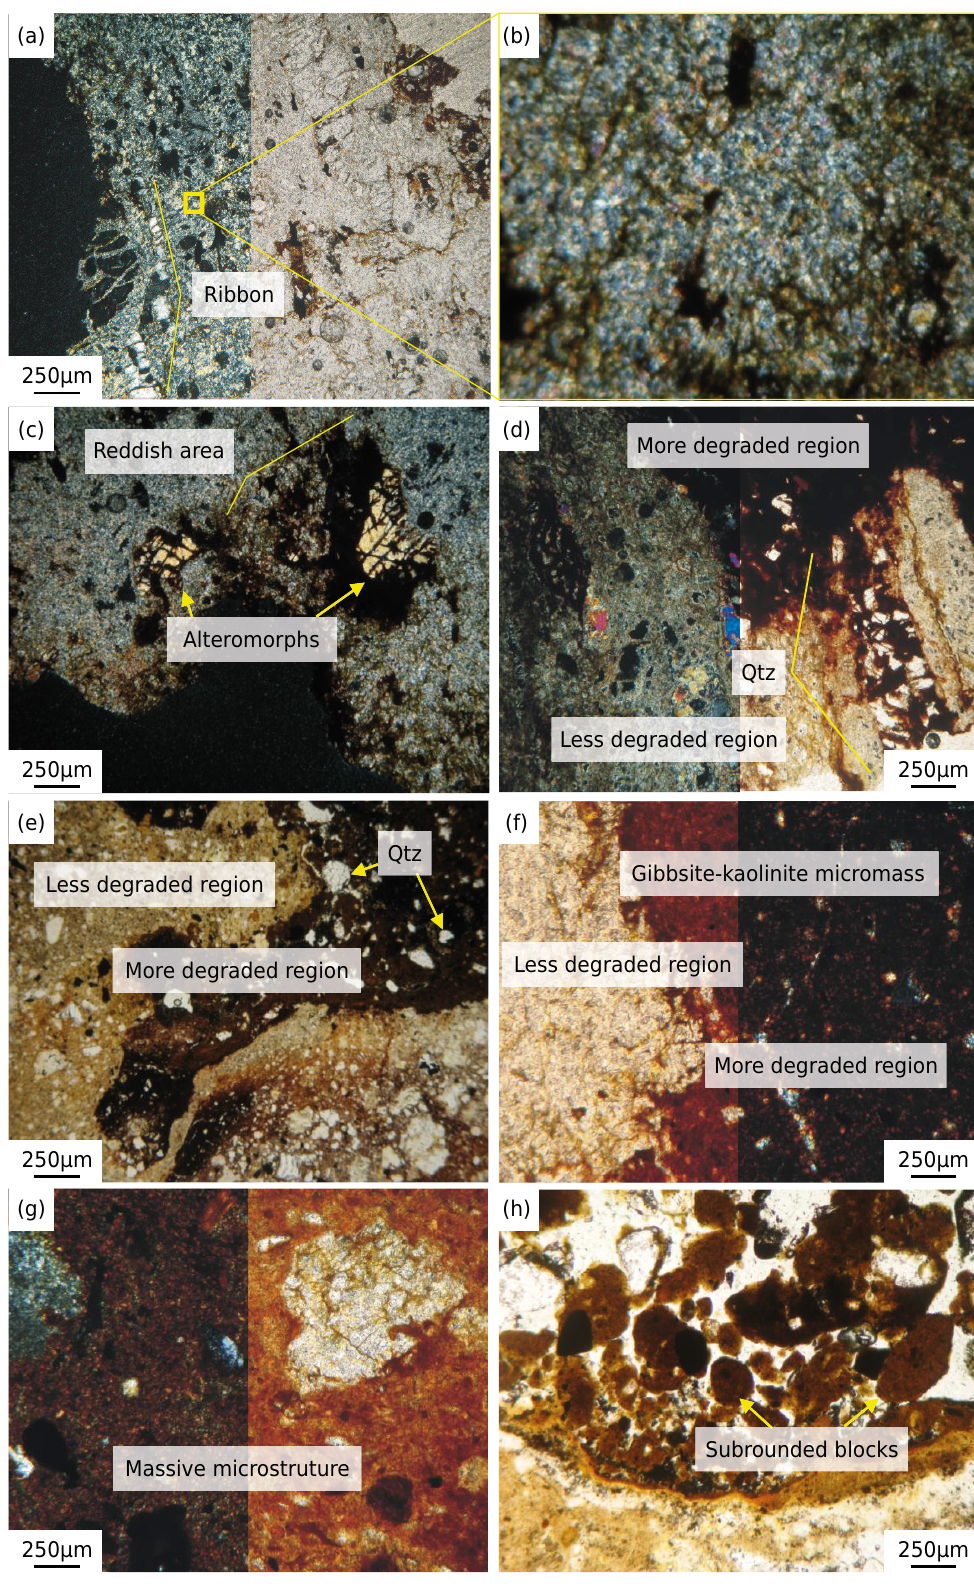
Figure 4. Photomicrograph of bauxite fragments. PPL: plane polarized light; XPL: crossed polarized light; Qz: quartz. (a) Less degraded bauxite fragment with preserved isalteritic structure and quartz ribbons. The micrograph on the right was taken under XPL and on the left under PPL. (b) Gibbsite micromass with crystalline b-fabric. (c) Bauxite fragment with a reddish region indicating the precipitation of iron oxide and the presence of ferromagnesian alteromorphs. (d), (e), and (f) Bauxite fragment with regions with varying degradation. The more degraded region consists of reddish-yellow gibbsite-kaolinite micromass, and the less degraded region consists of gibbsite micromass with crystalline b-fabric. Photomicrograph (d) shows the right side under XPL and the left side under PPL. (g) Massive microstructure, taken under XPL on the right and PPL on the left. (h) Microstructure with subrounded